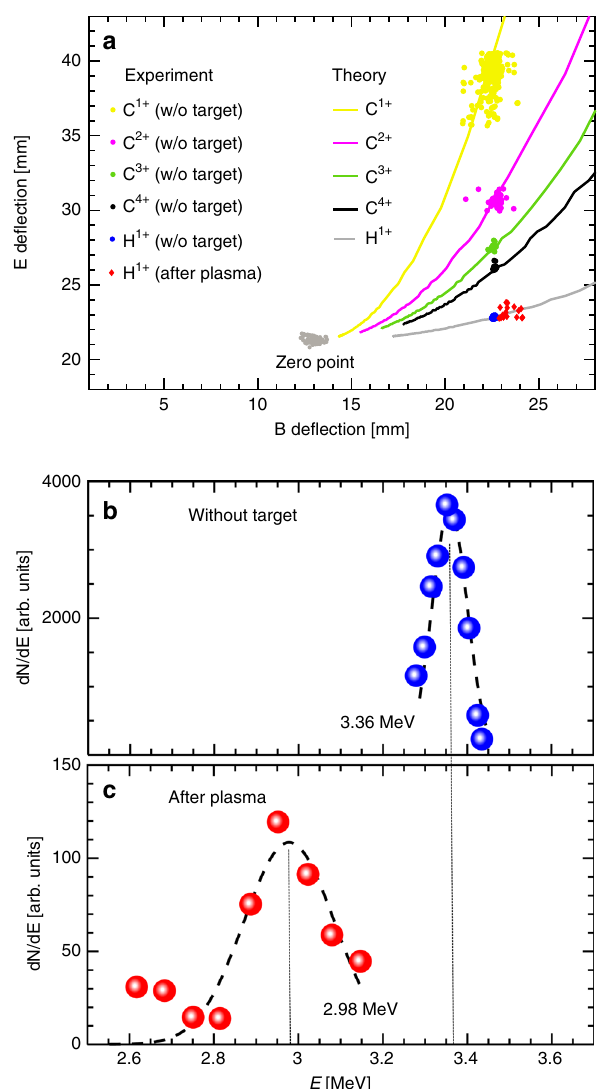
Fig. 2 TPS CR39 tracks of quasi-monoenergetic ions passing through the system with/without target and the converted energies of protons. a Tracks of ions recorded on TPS CR39 passing through null target and plasma target. The X and Y coordinates represent the magnetic and electric de fl ection distances. The dots with the same B de fl ection distance from up to down (yellow, magenta, green, black, and blue in order) represent tracks formed by C 1 + , C 2 + , C 3 + , C 4 + , and protons passing through the system without (w/o) target. Tracks for protons passing through the plasma are represented by red dots. The tracks for the zero reference point are indicated with gray dots. The solid curves represent the theoretical tracks of these ion species with various energies. b Energy spectra of the protons passing the system without target. The experimental distribution (blue dots) is well fi tted by a Gaussian pro fi le (dashed line) with central energy of 3.36 MeV (dotted line). c Energy spectra of the protons passing the system without target. The experimental distribution (blue dots) is fi tted by a Gaussian pro fi le (dashed line) with central energy of 2.98 MeV.